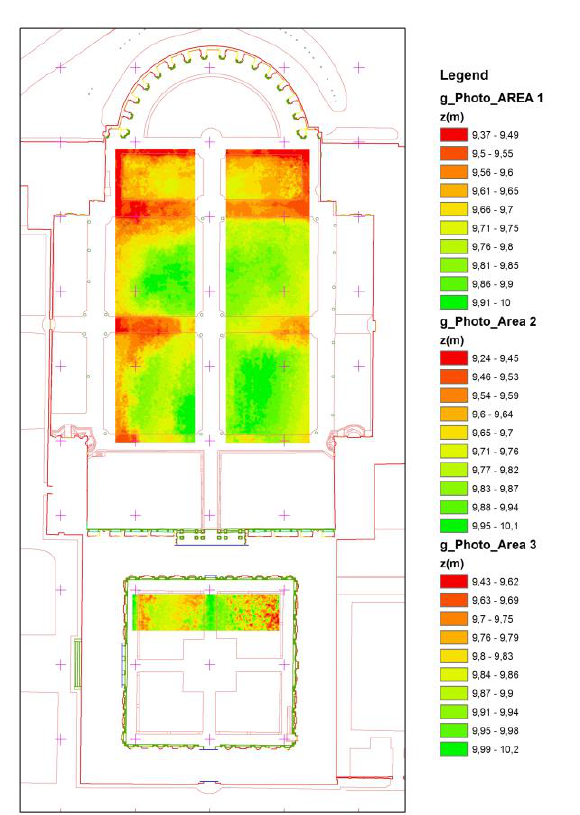
Figure 10. GRID – UAV, study areas.